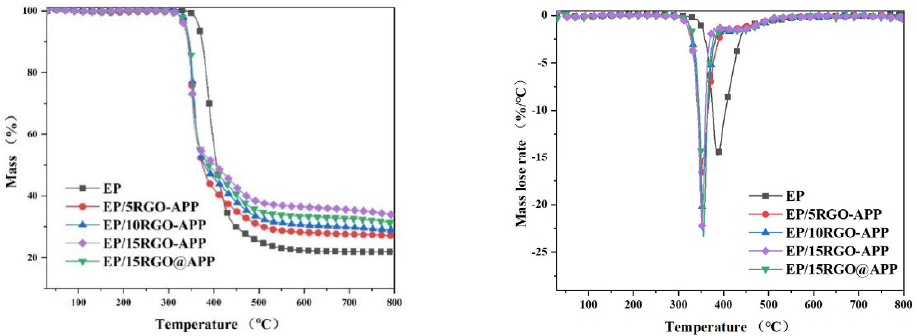
Figure 5. TG and DTG curves of pure EP and flame-retardant EP.